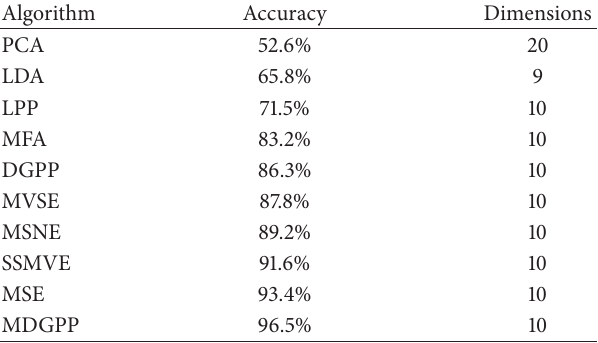
Table 3: Comparisons of recognition accuracy on the